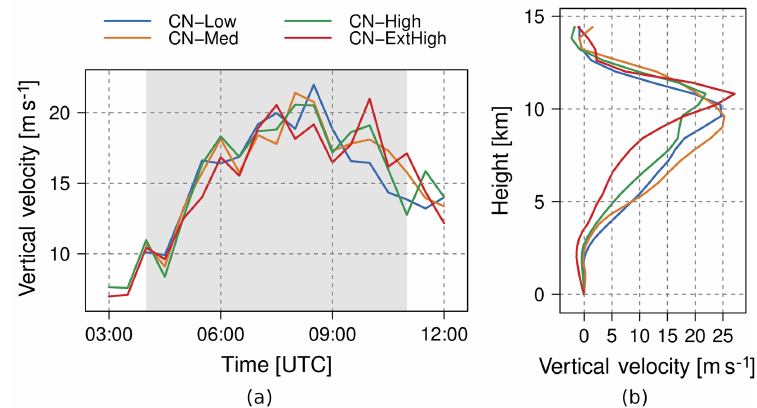
Figure 17. Average of the three highest updraft peaks throughout time (a) and strongest updraft profile (b) for the CN-Low (blue), CN-Med (marigold), CN-High (green) and CN-ExtHigh (red) experiments. The shaded area in grey represents the time period that the entire MCS is within the grid domain.